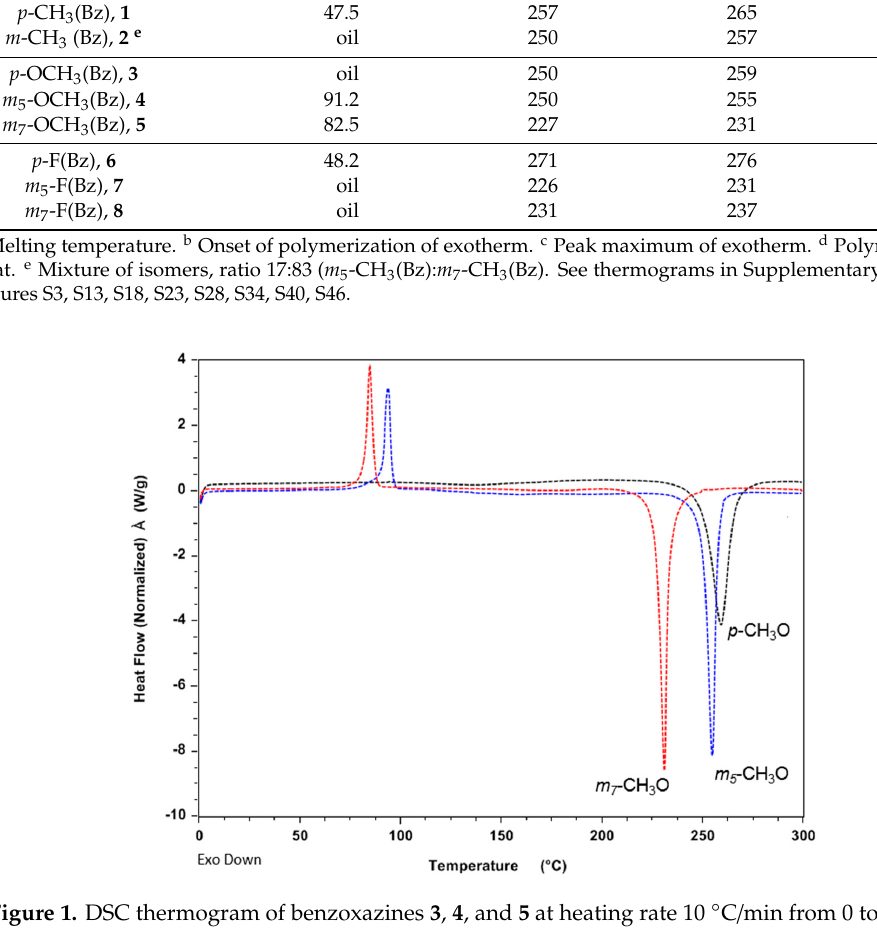
Figure 1. DSC thermogram of benzoxazines 3 , 4 , and 5 at heating rate 10 °C /min from 0 to 300